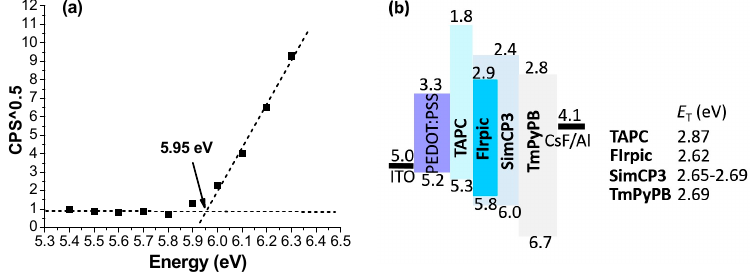
Figure 5. ( a ) Low-energy photoelectron spectra of SimCP3 ; ( b ) Energy level alignment of materials involved in OLEDs.